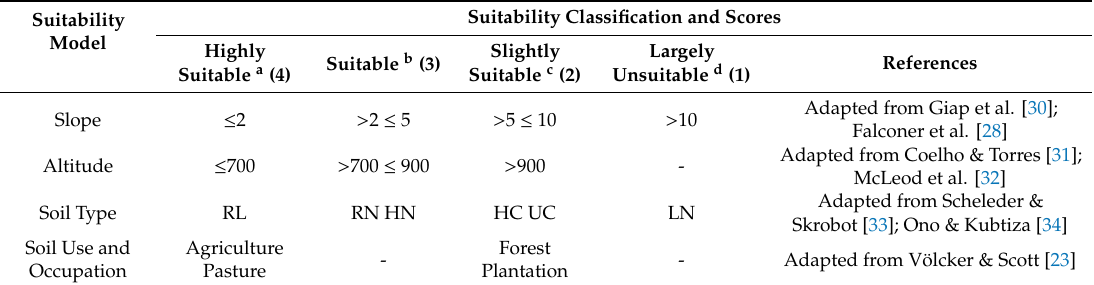
Table 1. Classification of suitability and scores for the suitability